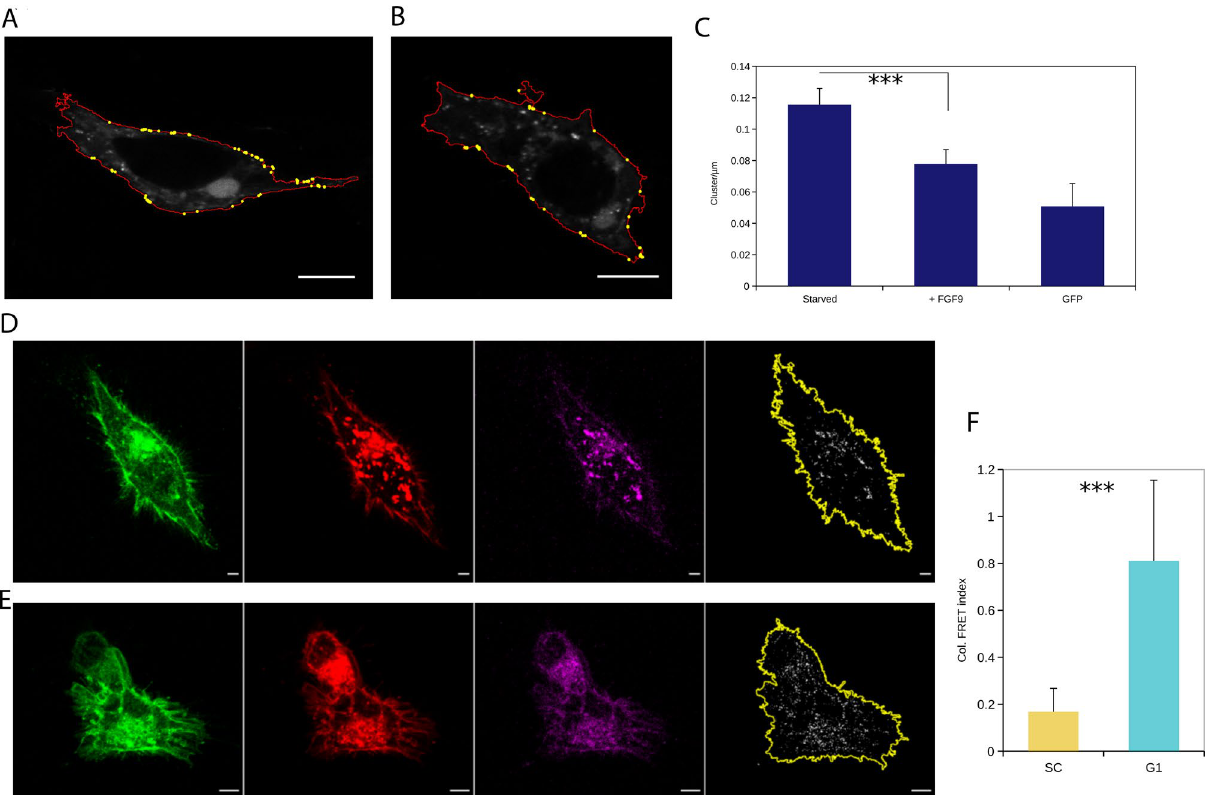
Figure 3. ( A – C ) Cluster identification of GRB2-split GFP dimer at the plasma membrane. ( A ) Serum starved, ( B ) 20 min. after FGF9 stimulation. Scale bar = 5 µm. ( C ) Quantification of GRB2 dimer clusters per µm. Significant difference between serum starvation and FGF9 stimulation ( p = 0.0006). ( D – F ) FRET measurement of serum starved HEK293T transfected with FGFR2-GFP and FGFR2-mCherry to determine dimerisation of receptor. ( D ) Control cells (SC), ( E ) GRB2-depleted cells (G1). Left to right: Donor (FGFR2-GFP), Acceptor (FGFR2-mCherry), FRET signal, integrated FRET area. Scale bar = 5 µm. ( F ) Quantification of integrated complete FRET area ( p < =